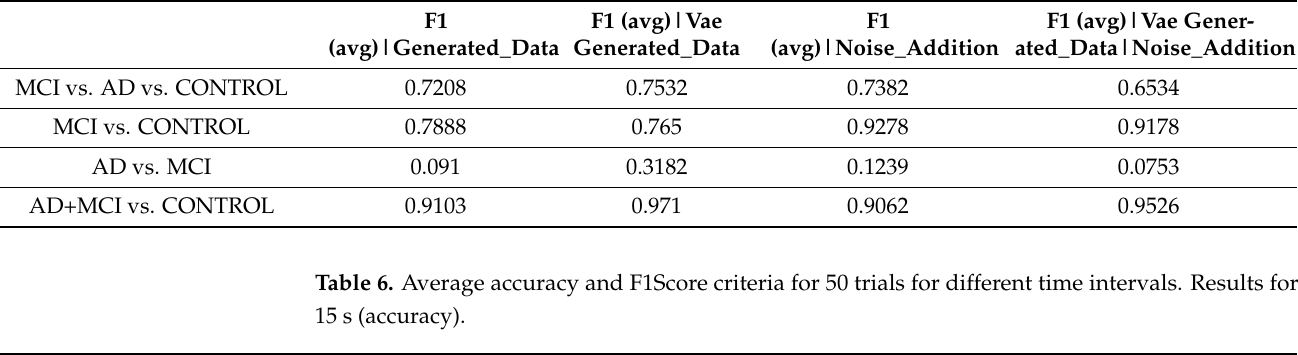
Table 5. Average accuracy and F1Score criteria for 50 trials for different time intervals. Results for 10 s (F1).